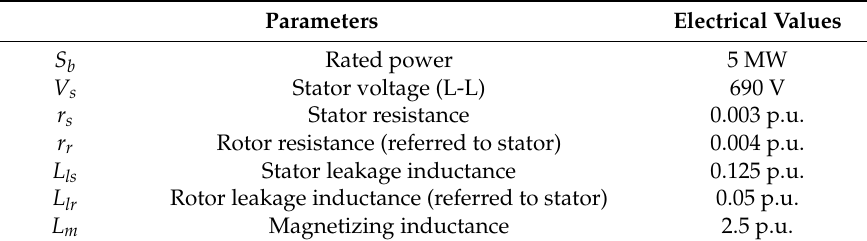
Table A1. 5 MW doubly fed induction generator (DFIG) parameters.